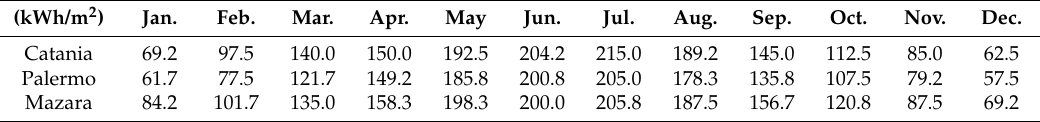
Table 4. Monthly solar radiation in the three sites: Catania, Palermo, and Mazara del Vallo [51].